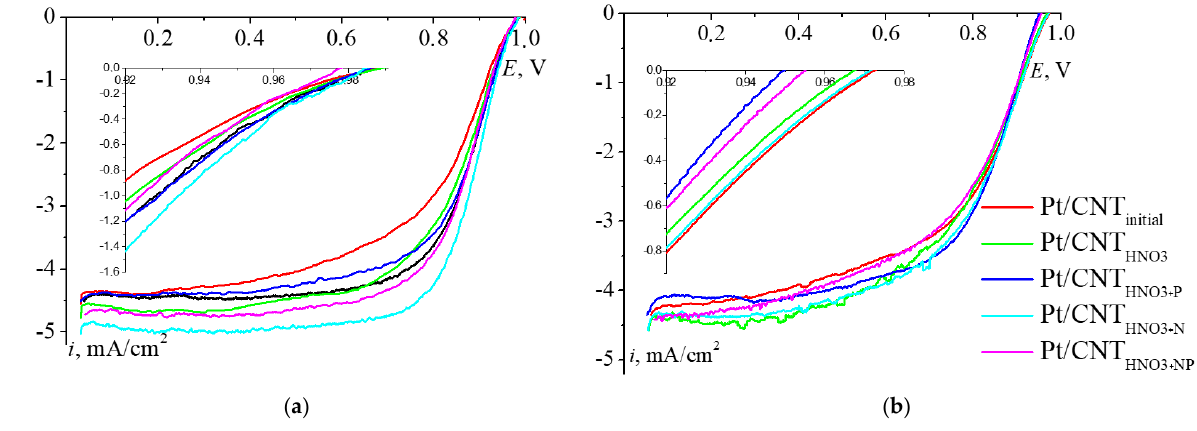
Figure 3. Polarization curves on Pt catalysts: ( a ) 0.1 M KOH; ( b ) 0.5 M H 2 SO 4 . O 2 ; the potential scan rate is 5 mV/s; m kat =